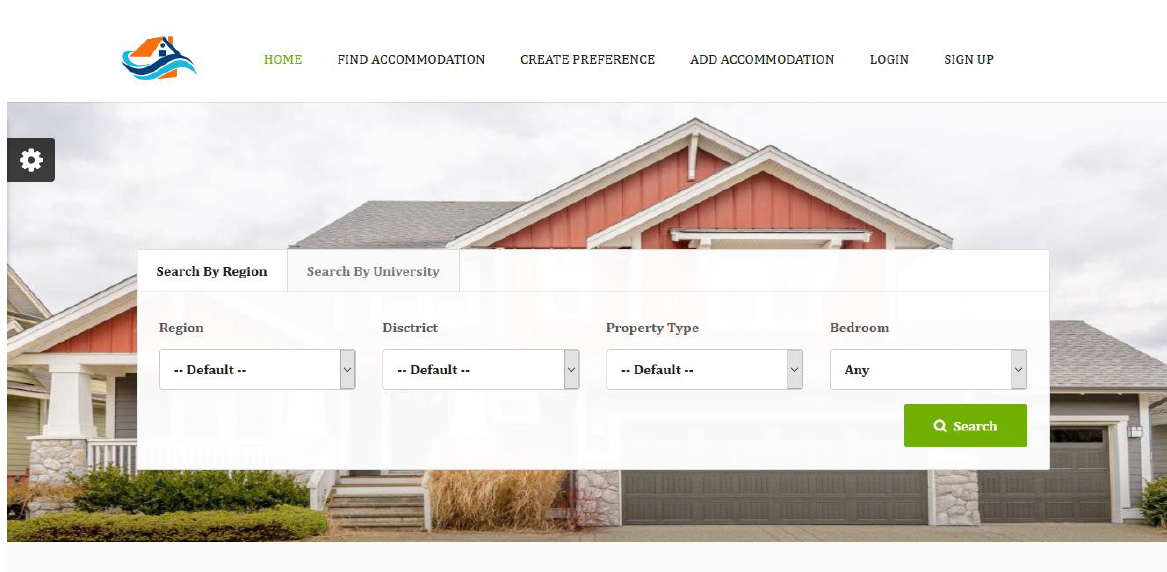
Figure 14. Interface for Searching for